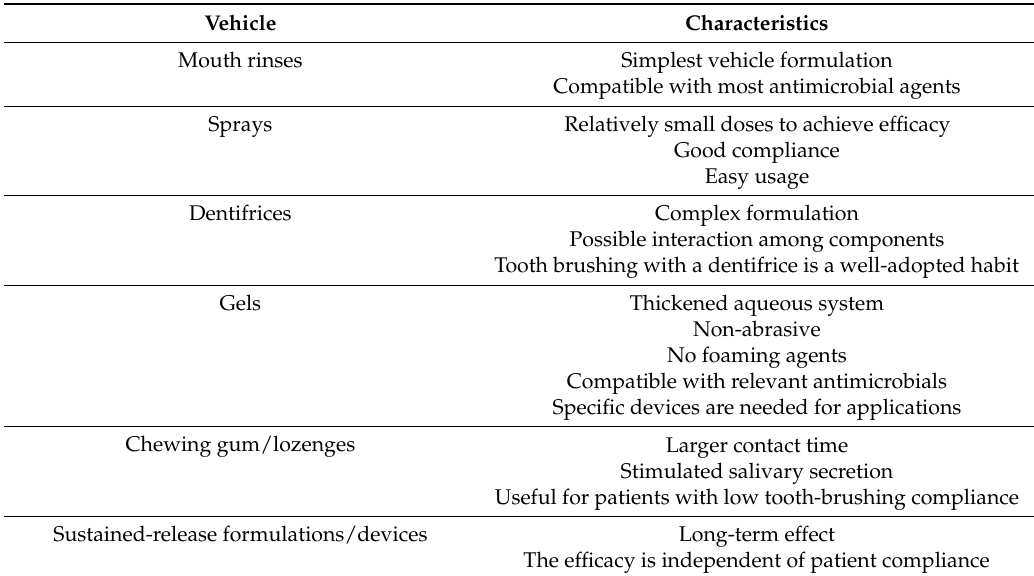
Table 3. Delivery formulations used in oral